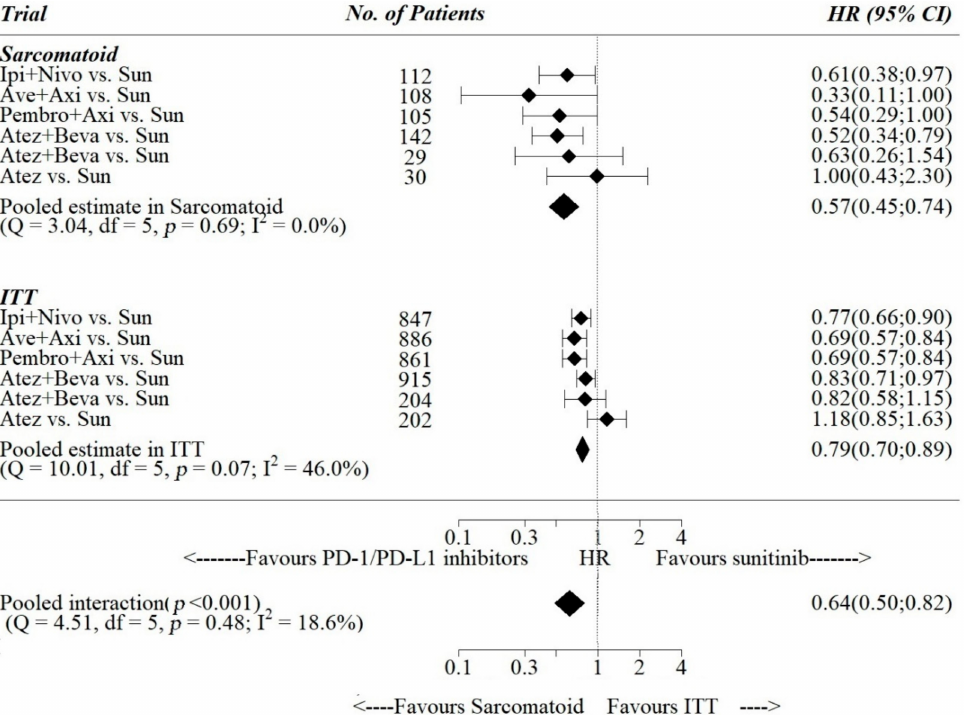
Figure3. InteractionsbetweenHRforprogressionordeathandsarcomatoidhistology. Ipi = Ipilimumab; Nivo = Nivolumab; Sun = Sunitinib; Ave = Avelumab; Axi = Axitinib; Atez = Atezolizumab; Beva =